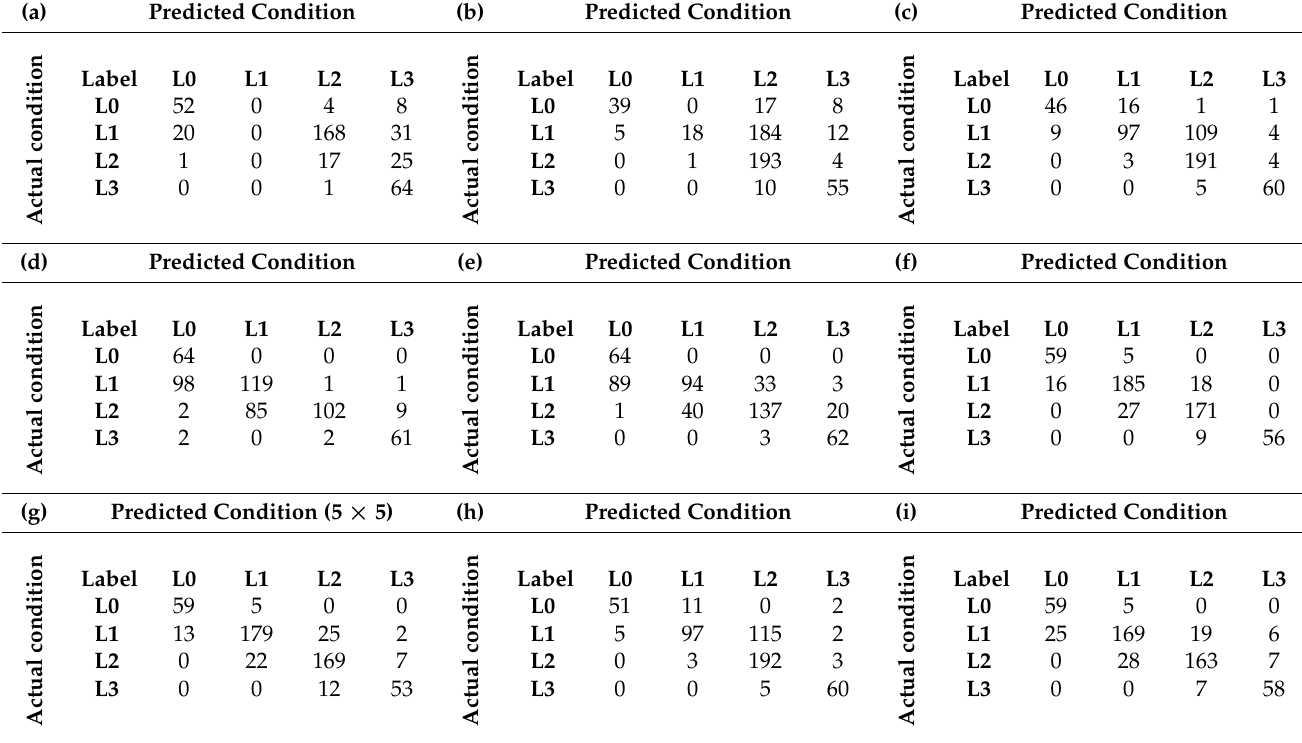
Table 8. Confusion matrices of MobileNetV2 (a), InceptionResNetV2 (b), ResNet50 (c), SVM (d), RF (e), DS-SoybeanNet with kernel sizes of 5 × 5 (f) and 7 × 7 (g), AlexNet (h), and VGG16 (i).